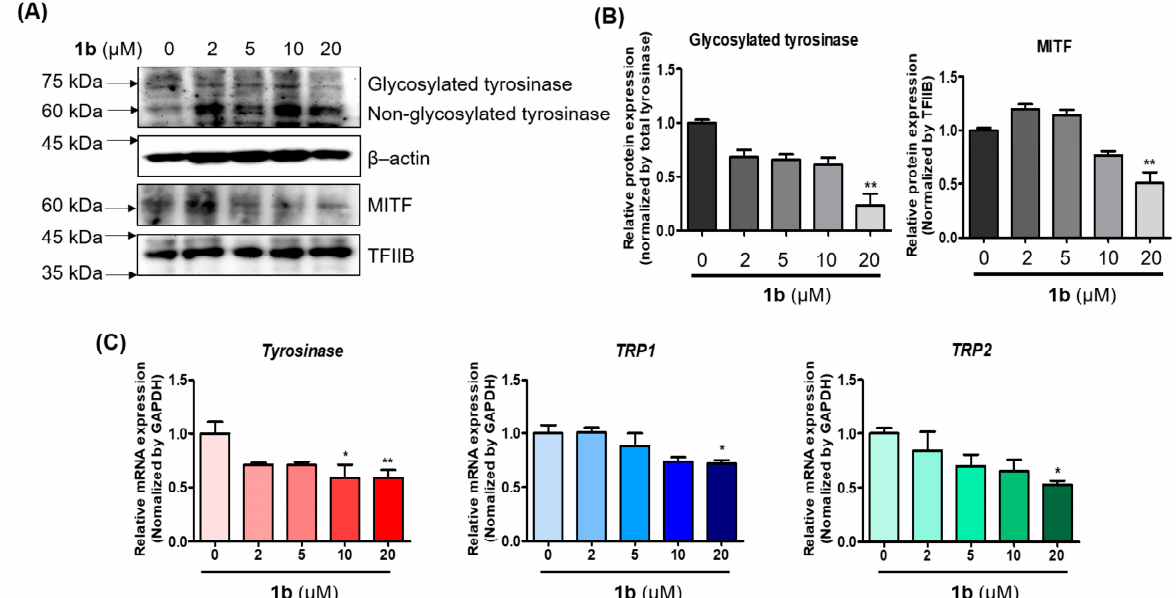
Figure 11. The effects of compound 1b on the expressions of the TRP-1 , TRP-2 , and tyrosinase genes in B16F10 cells. Protein levels of non-glycosylated and glycosylated tyrosinases, and MITF in compound 1b -treated B16F10 cells were calculated using Western blotting of nuclear and cytosolic fractions of cell total lysates, respectively ( A , B ). TFIIB and β -actin were used as loading controls for nuclear and cytosolic fractions, respectively. ( C ) The mRNA expressions of TRP-1 , TRP-2 , and tyrosinase in cells exposed to compound 1b for 24 h were analyzed by qRT-PCR using GAPDH mRNA as an internal control. Primer sets are displayed in Table 1. Data are indicated as means ± SEMs. The symbol * indicates significant differences between groups: ** p < 0.01 and * p < 0.05 for 1b -treated cells versus untreated controls.